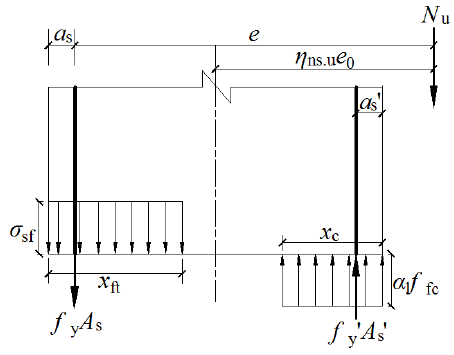
Figure 15. The bearing capacity under a large eccentric compression load on a normal section of the column.